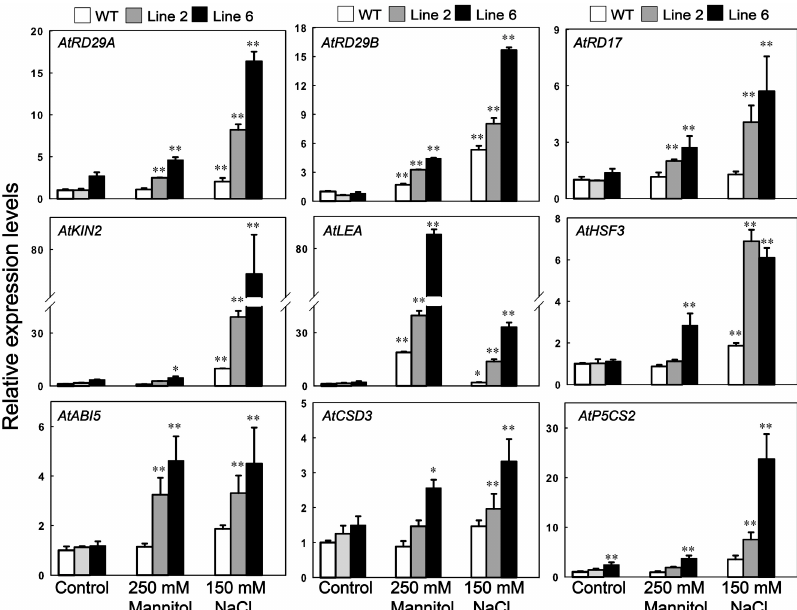
Figure 6. Gene expression level analysis of potential downstream genes of ScDREB10 in response to osmotic and salt stresses. One-week-old seedlings of WT and transgenic Arabidopsis cultured on MS medium were transferred on the MS agar plates (control), MS agar plates supplied with 250 mM mannitol (osmotic stress) or 150 mM NaCl (salt stress), and maintained for 7 days. Abiotic stress-responsive genes were analyzed by RT-qPCR in WT and ScDREB10 transgenic plants after osmotic and salt treatments. Total RNAs were extracted from leaves, and RT-qPCR analysis was performed. The 2 − ∆∆ C t method was used in RT-qPCR analysis. The α -TUBULIN (At1g50010) and UBIQUITIN10 (At4g0532) genes of Arabidopsis were used as the reference genes. Values are means ± SE of three replicates. Asterisks indicate statistically significant differences from WT (* P < 0.05, ** P <